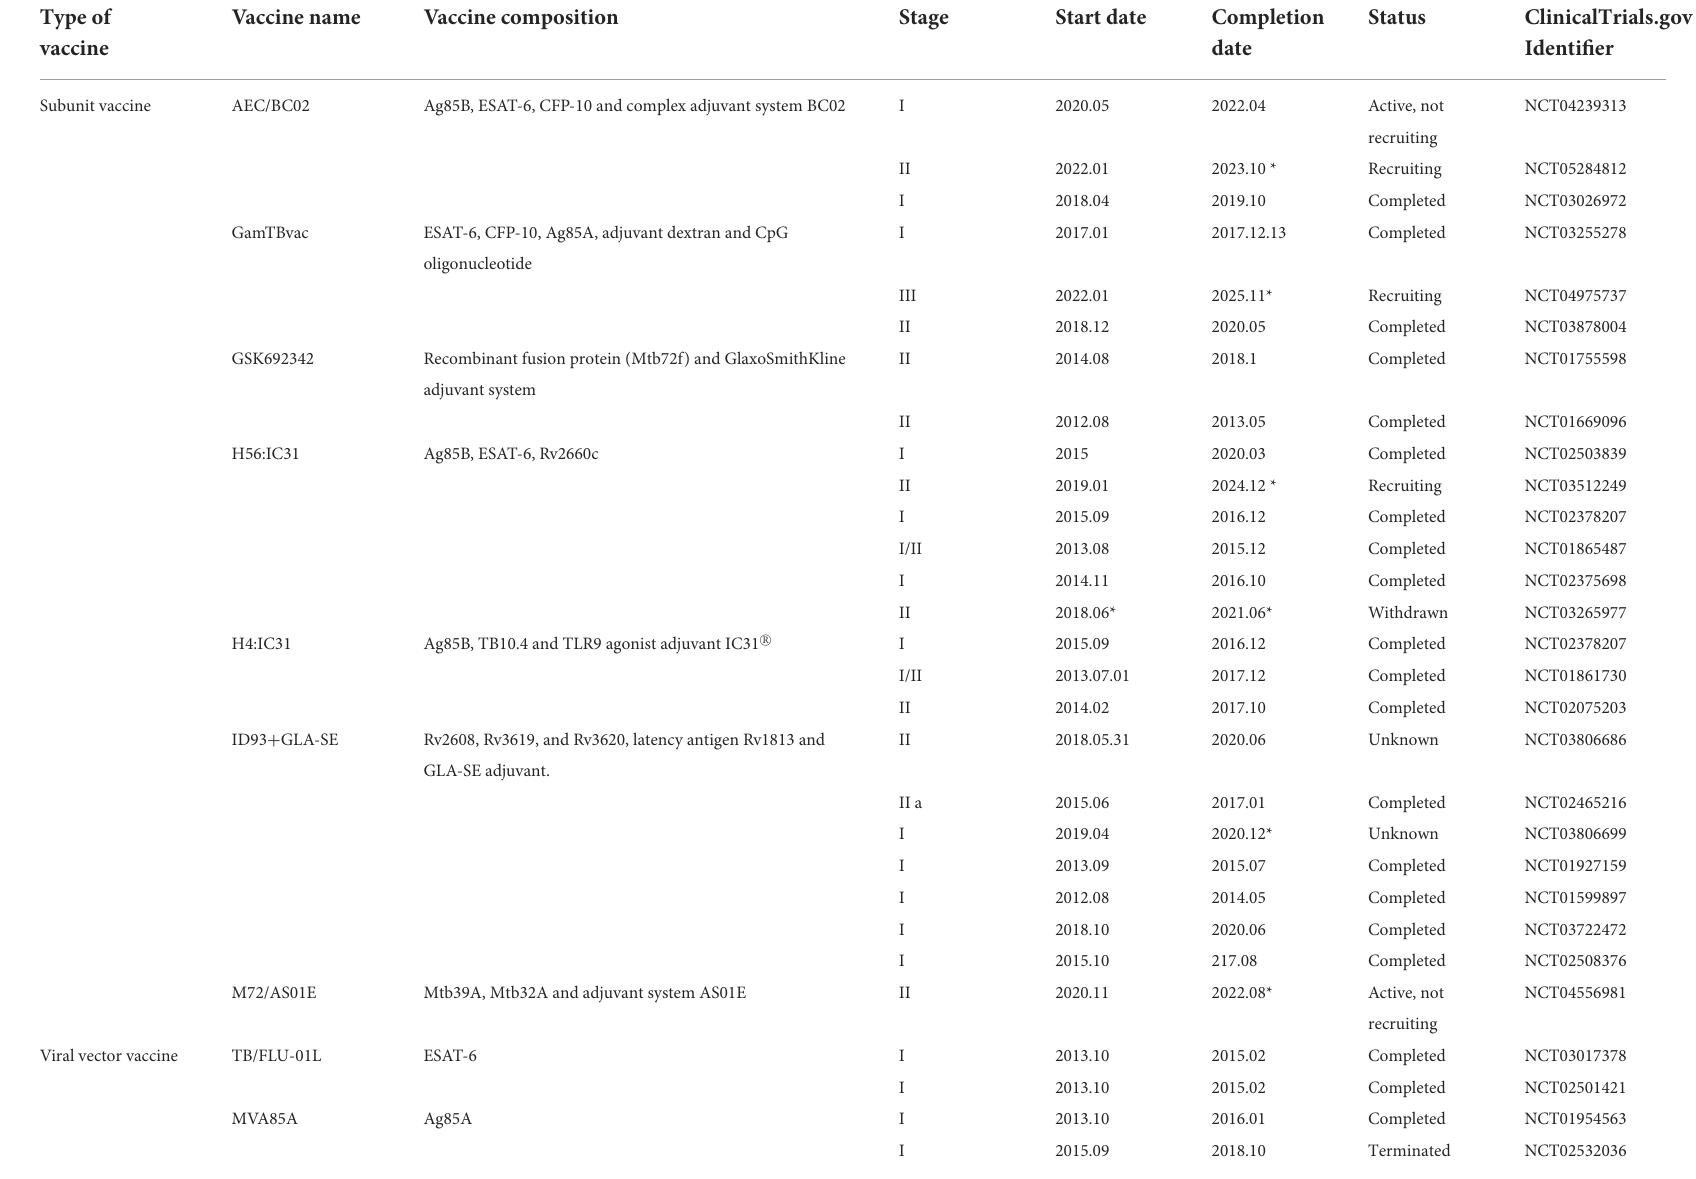
TABLE 5 The clinical trials of TB vaccines in recent